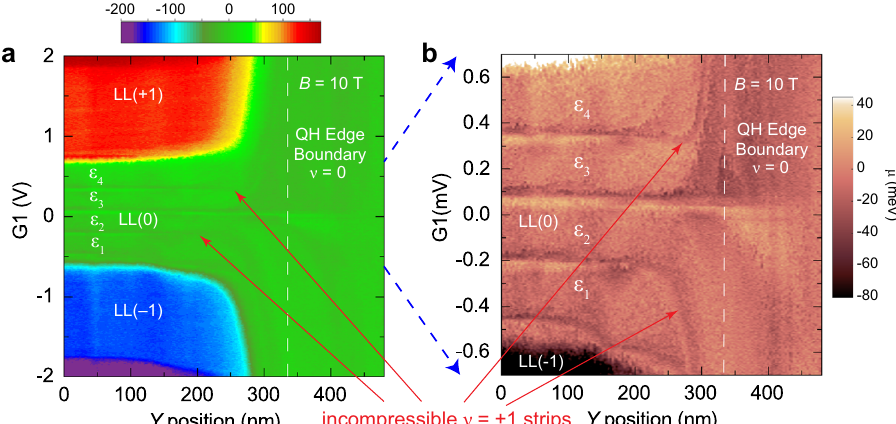
Fig. 5 Spatial dispersion of graphene broken-symmetry edge states at the quantum Hall edge boundary. a Kelvin probe map at B ¼ 10T of the chemical potential as a function of Y -position across the QH boundary and local gate potential. In the local gated area, Landau levels from N ¼ (cid:2) 2 [LL( (cid:2) 2)] to N ¼ þ 2, [LL( + 2)], are seen in the different colored plateaus. Incompressible signatures due to the large excursions in the chemical potential (see Fig. 3d) are observed inside the N ¼ 0 Landau level corresponding to fi lling factors ν ¼ 0 ; ± 1. b Higher-resolution Kelvin probe map of the N ¼ 0 Landau level showing that at the quantum Hall edge boundary the ν ¼ ± 1 channels disperse away from the ν ¼ 0 center line. AFM settings: 2 nm oscillation amplitude, 4 f ¼ (cid:2) 2Hz, 20 mV bias